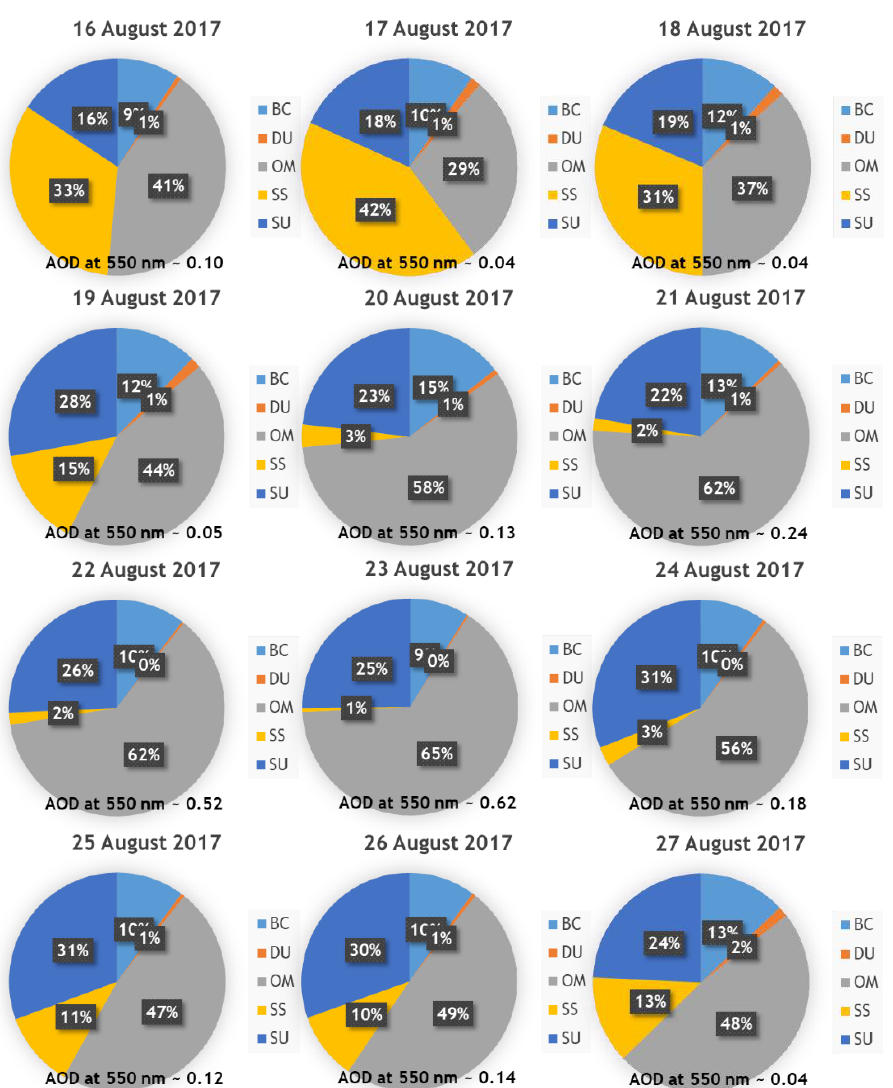
Figure 13. Daily percentage of each chemical component at 550 nm aerosol optical depth in Hornsund between 16 and 27 August 2017 compared with aerosol optical depth at 550 nm.